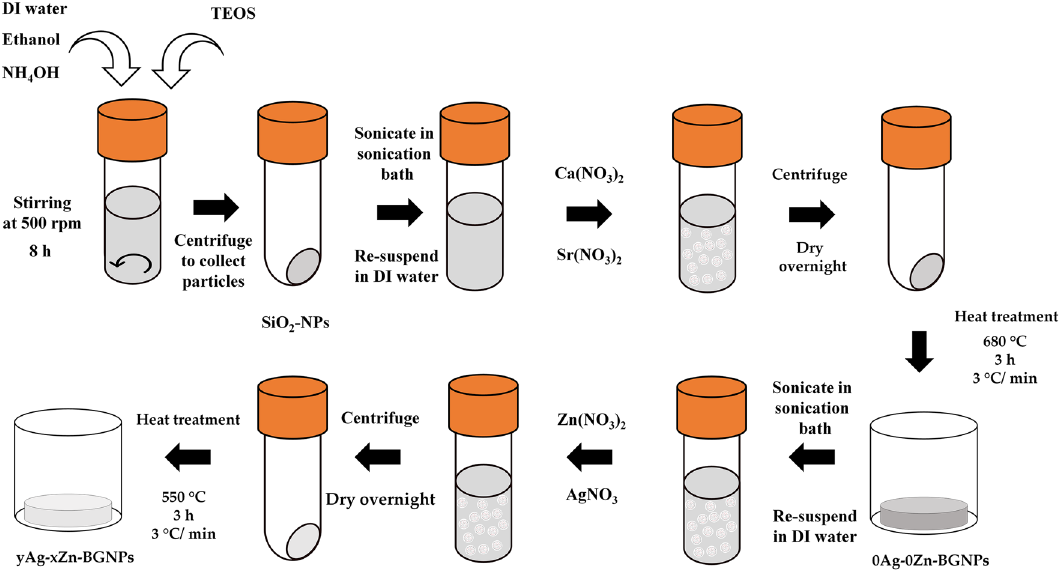
Figure 12. Synthesis process of Zn- and Ag–doped sol–gel-derived